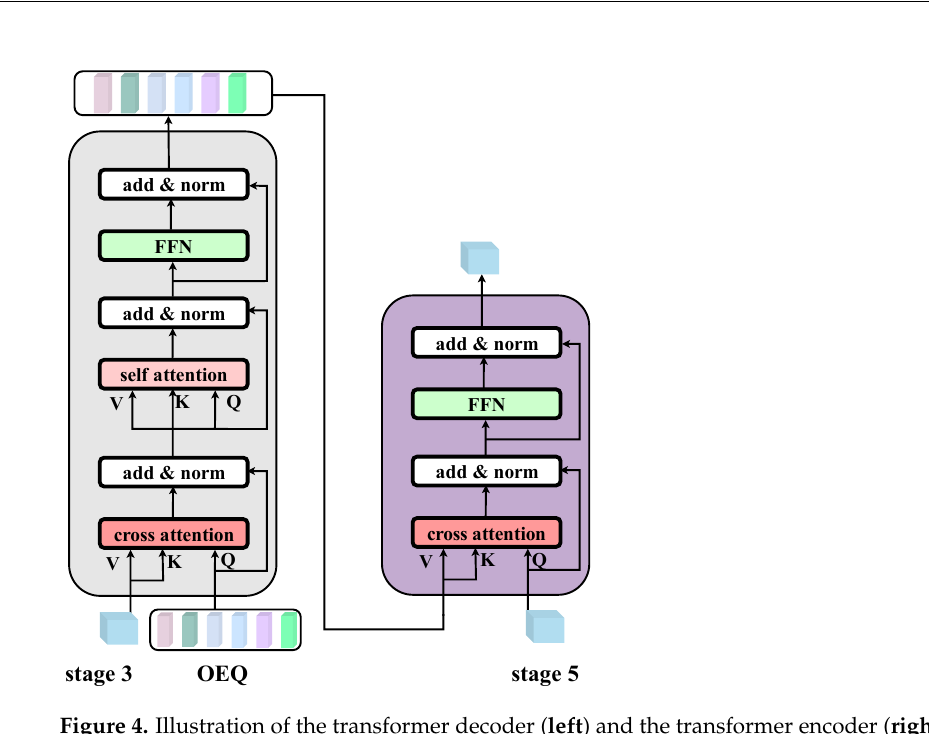
8 of 20 Figure 3. Hierarchical structure for spatial feature extraction. ( a ) The simplified feature pyramid (SFP) module pipeline. ( b ) The add method in SFP. ( c ) The concatenation method in SFP. 3.2. Object Embedding Queries and Decoder Cross-Attention The label that each pixel has expressed is the semantic label of the object in which the pixel is located. Based on this concept, we use a set of learnable object embedding queries (OEQs) 𝐴 to aggregate the contexture features of all pixels through category objects. As shown in Figure 4 (left), the object embedding queries structure the image into 𝑁 object regions, represented as 𝐴 , train it interactively with the four stages of features ex- pressed through the feature fusion module SFP in the transformer decoder module with different stages of pixel-level features for the purpose of aggregating each pixel represen- tation in the image. The transformer containing the decoder cross-attention used in this paper uses a sim-